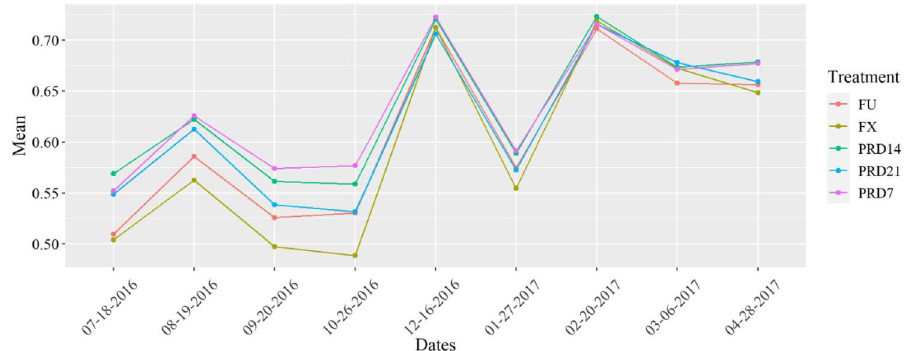
Figure 8. Temporal values of NDVI obtained from PlanetScope constellation in different PRD techniques, PRD 7—alternation every 7 days along the whole cycle; PRD 14—alternation every 14 days along the whole cycle; PRD 21—alternation every 21 days along the whole cycle; FX—fixed irrigation on one side of the plant; and FU Control-full